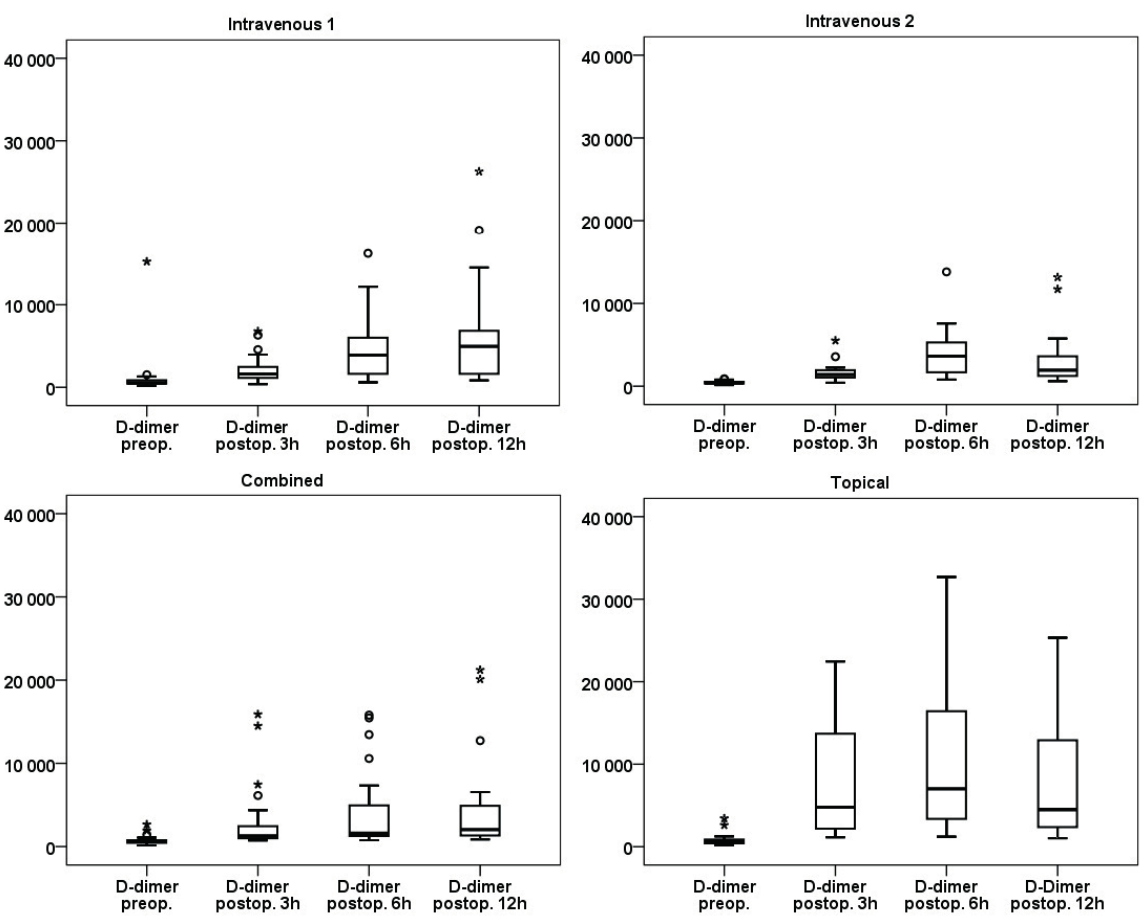
Fig. 1. Comparison of the level of D-dimers for each TXA group after 3, 6 and 12 h after the start of the